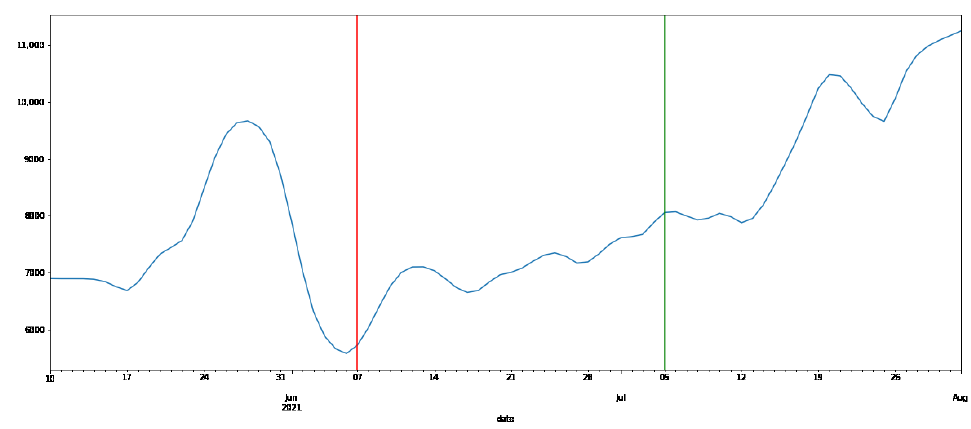
Figure 5. Trend component of